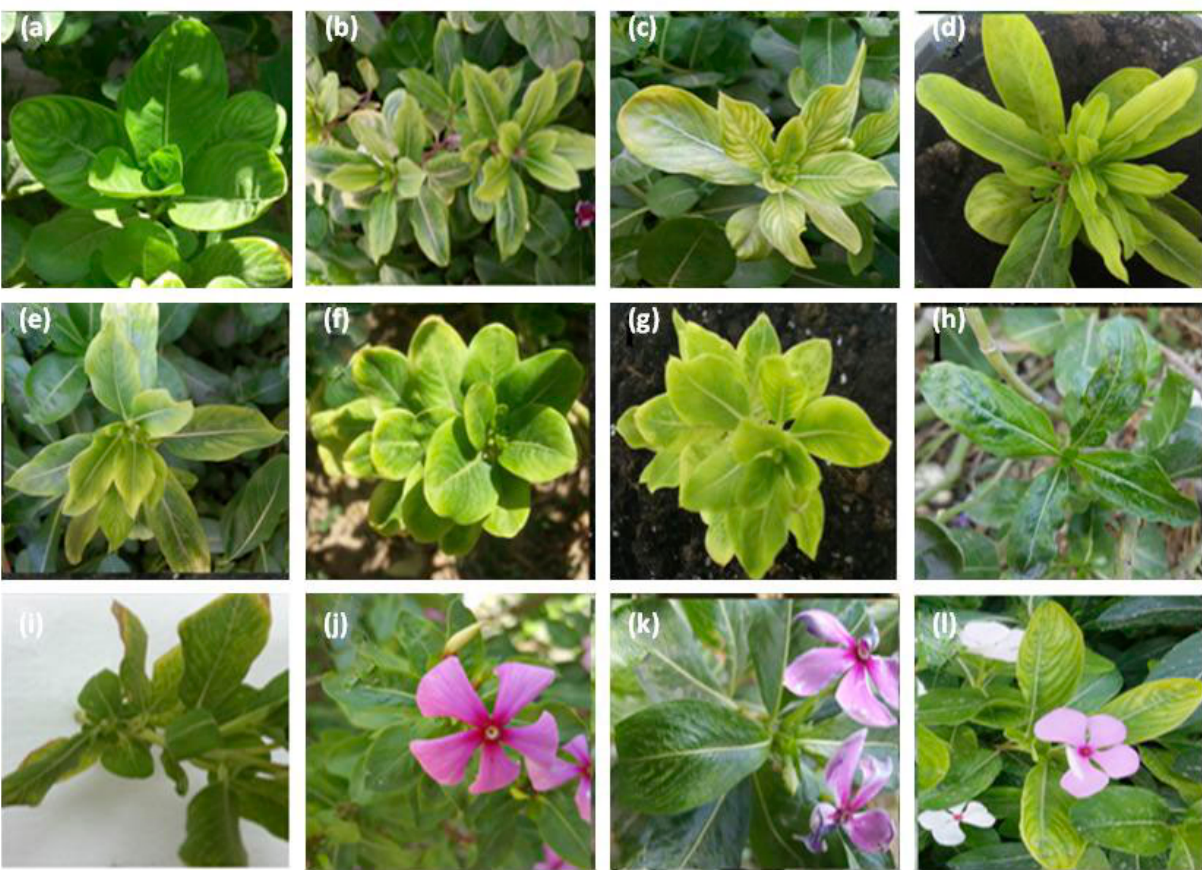
Figure 1. Periwinkle plants exhibiting different types of symptoms observed in inspected nurseries, gardens, orchards and landscape plantings in different provinces of the Kingdom of Saudi Arabia. (a) healthy periwinkle plant; (b) leaf distortion; (c) chlorosis; (d) yellowing; (e) deformation of apical leaves; (f) fleck (g) mottling; (h) mosaic; (i) rosette and stunting; (j) blotching and flower distortion; (k) vein clearing and flower variegation; (l) vein necrosis and